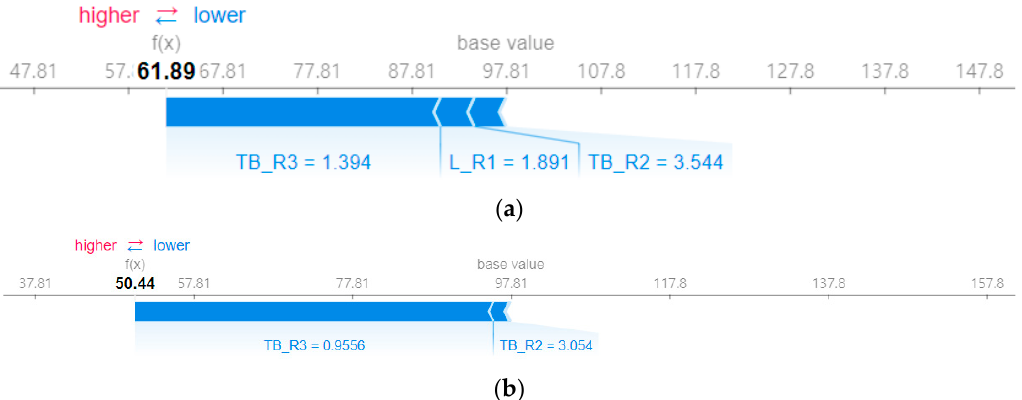
Figure 8. SHAP force plot. ( a ) Datum observed at 23:00 on 4 March 2021. ( b ) Datum observed at 00:00 on 5 March 2021.